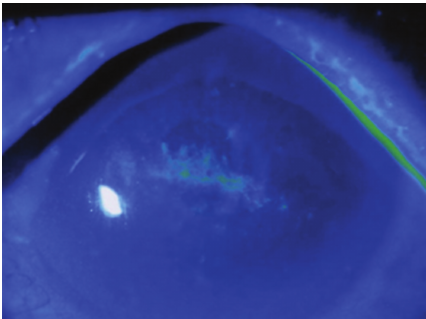
Figure 1: Fluorescein staining at the initial consultation. Corneal erosion and an epithelial crack line were observed in the corneal center.